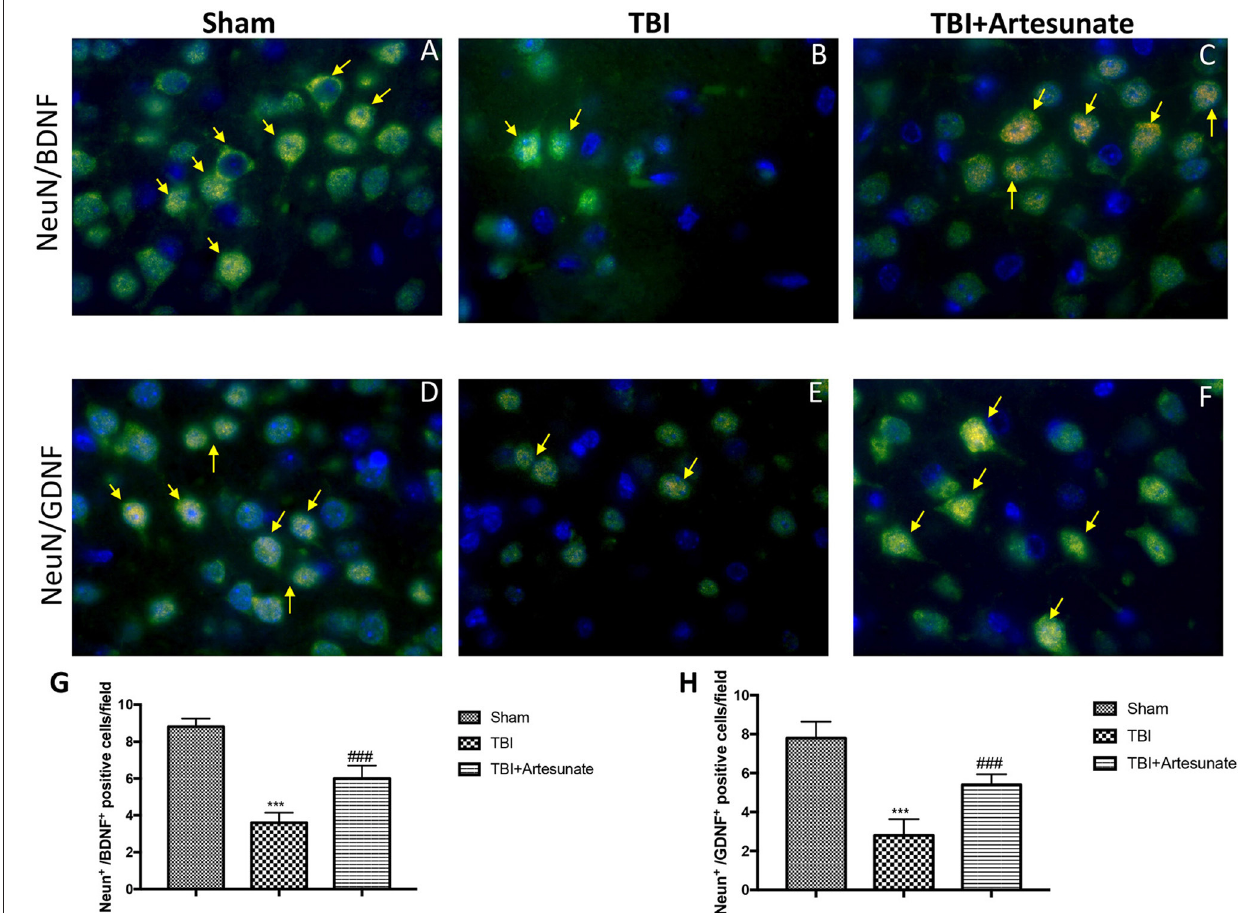
FIGURE 9 | Protective effect of artesunate treatment on co-localization between BDNF and GDNF with Neu-N. (A,D) Showed the co-localization between BDNF + /Neu-N + and GDNF + /Neu-N + respectively in sham brain tissue. Twenty-four hours after TBI injury in brain tissue there is a significant decrease in positive cells for BDNF + /Neu-N + and GDNF + /Neu-N + as show in (B,E) respectively. Treatment with artesunate significantly increased the release of BDNF and GDNF as show in figure (C,F) respectively. (G,H) Represent, respectively, densitometric analysis. The yellow arrow indicates the co-localization between BDNF and Neu-N and GDNF and Neu-N. Data are expressed as Mean ± SEM from N = 10 Mice for each group, *** P < 0.001 vs. corresponding sham group. ### P < 0.001 vs. corresponding TBI. ( F -value for BDNF + /Neu-N + = 101.6. df = 2. r 2 = 0.9442) ( F -value for GDNF + /Neu-N + = 55.18. df = 2. r 2 =